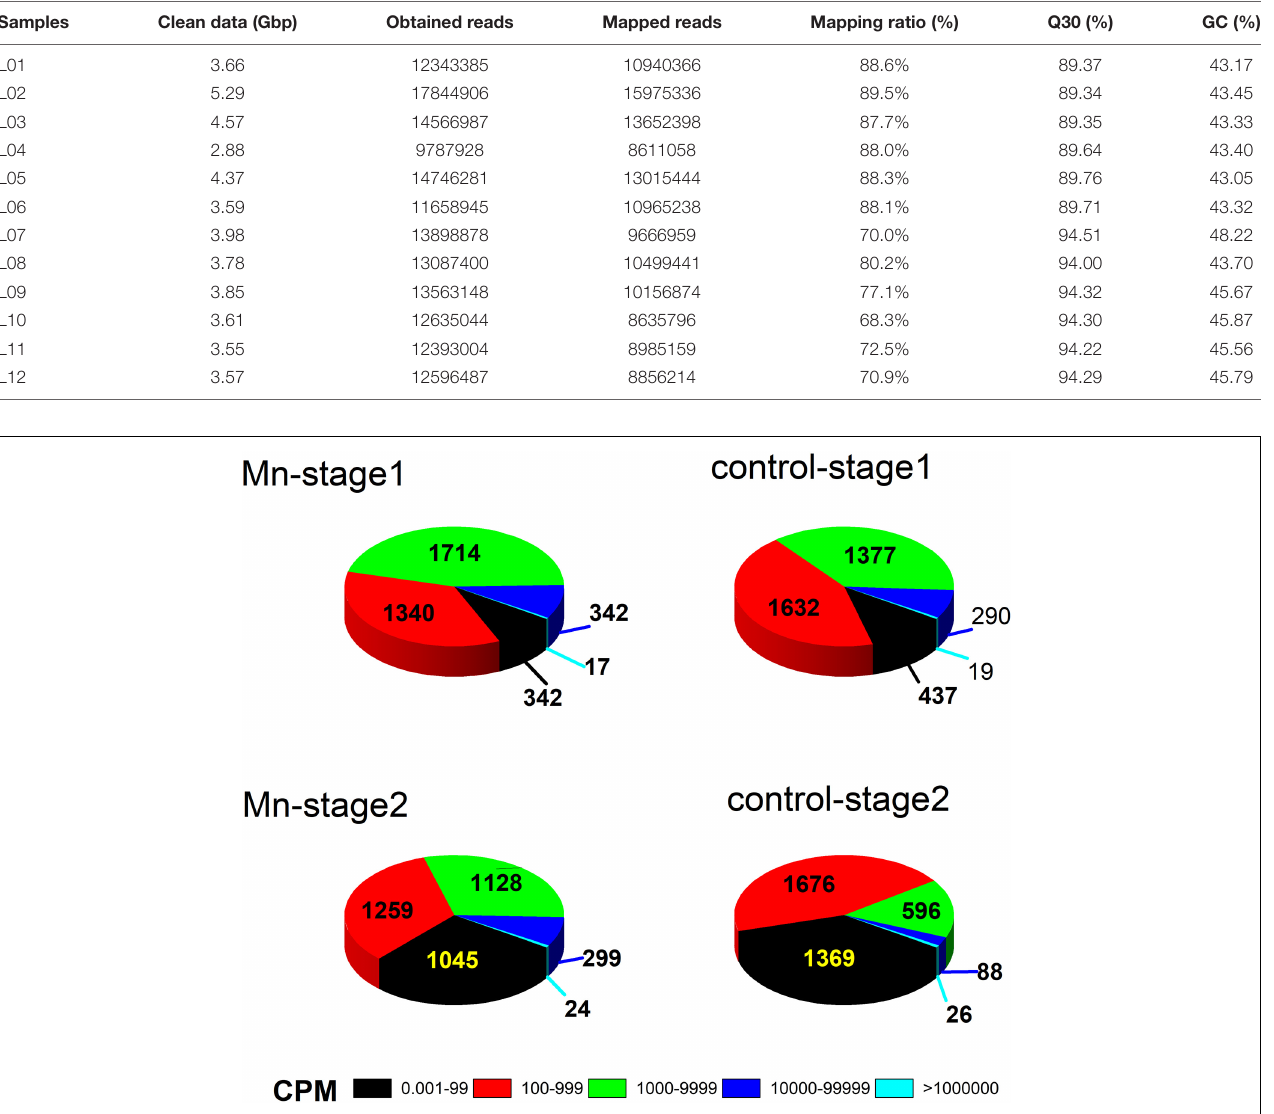
FIGURE 1 | Gene expression patterns of strain ST7 in the presence of Mn(II) at exponential (stage 1) and stationary (stage 2) growth phases.